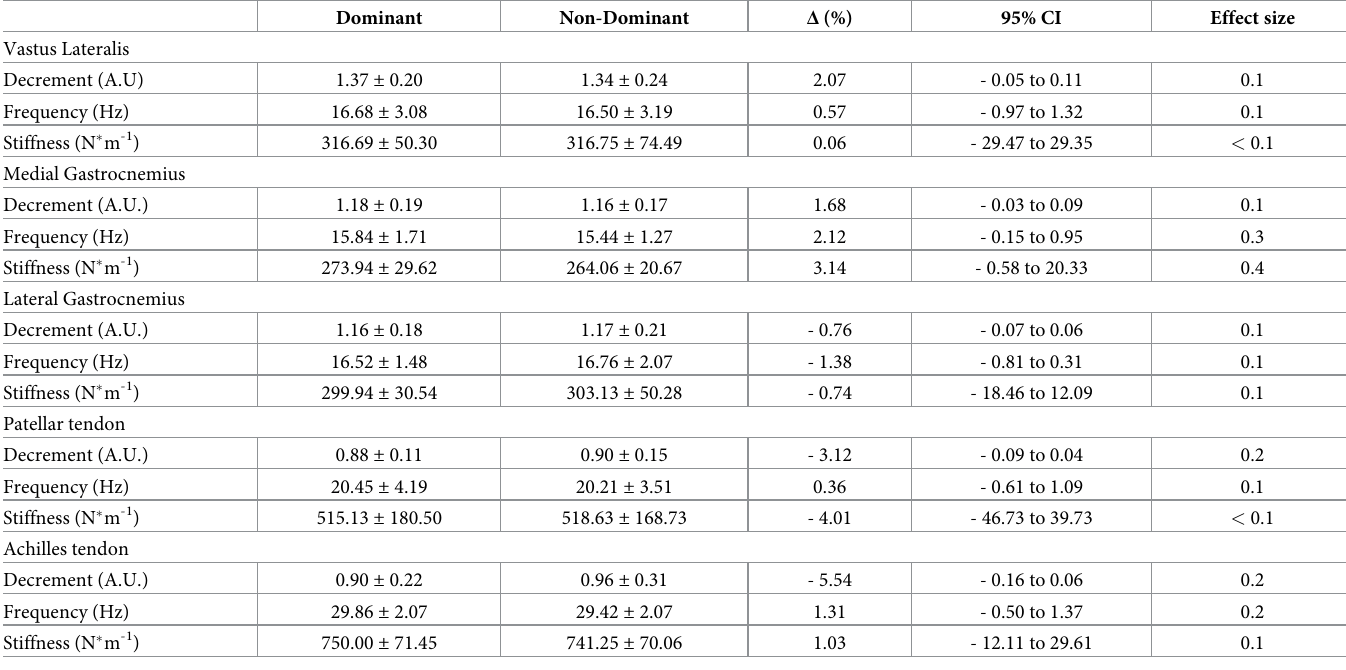
Table 2. Myometric data of muscles and